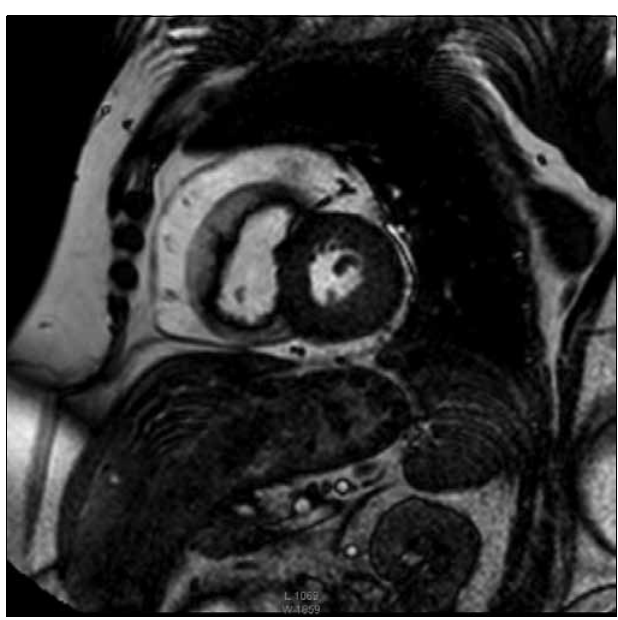
Fig. 1. Short axis bright blood BTFE image. TR=3.4, TE=1.7, Flip=60.